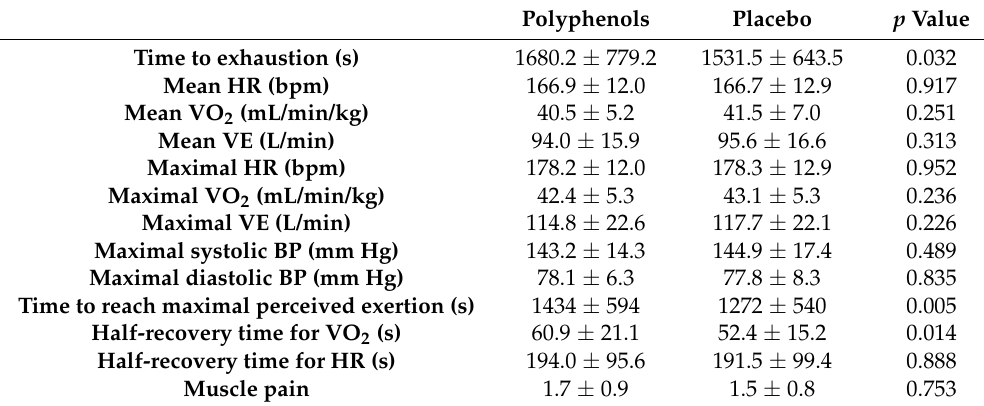
Table 2. Parameters recorded during and after endurance tests in polyphenols and placebo